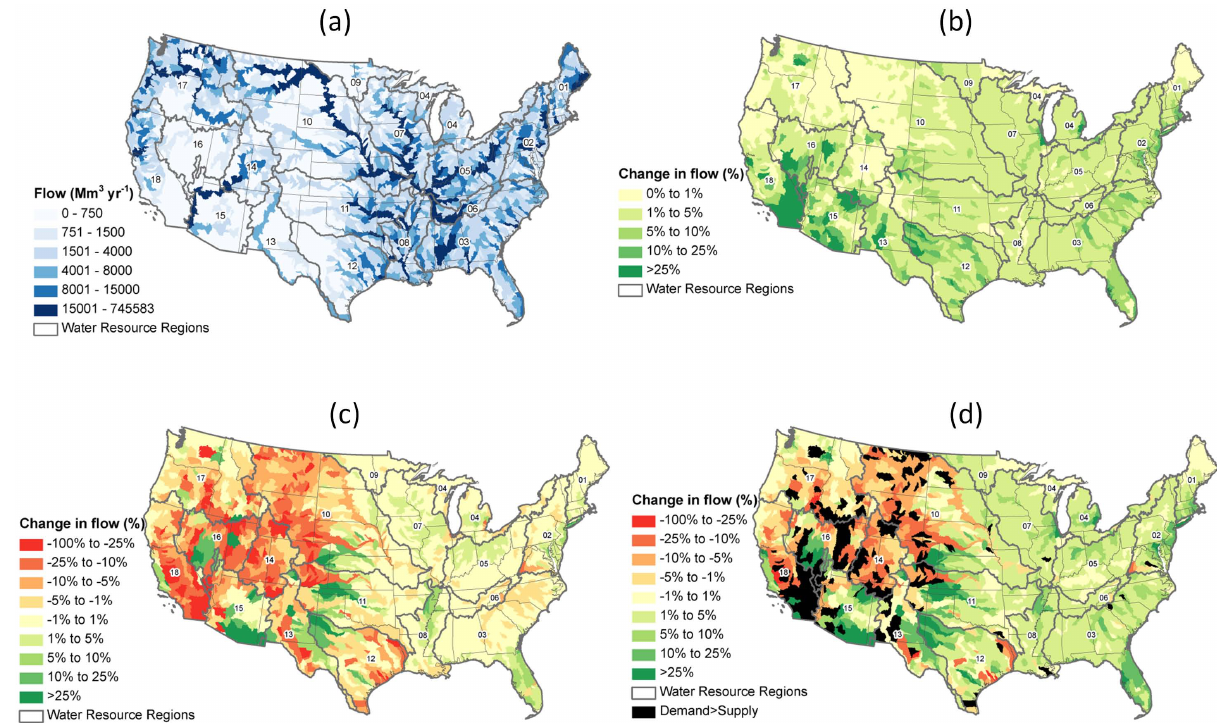
Fig. 4. 1981–2000 mean annual flow (Mm 3 yr − 1 ) assuming no net surface water withdrawals and no impervious cover (a) , and change in mean annual flow due to 2010 impervious cover (b) , 2005 withdrawals (c) , and both 2010 impervious cover and 2005 withdrawals (d) . Gross demand in black areas in (d) is greater than the sum of surface water supply and groundwater withdrawals, indicating likely transfer of water from other